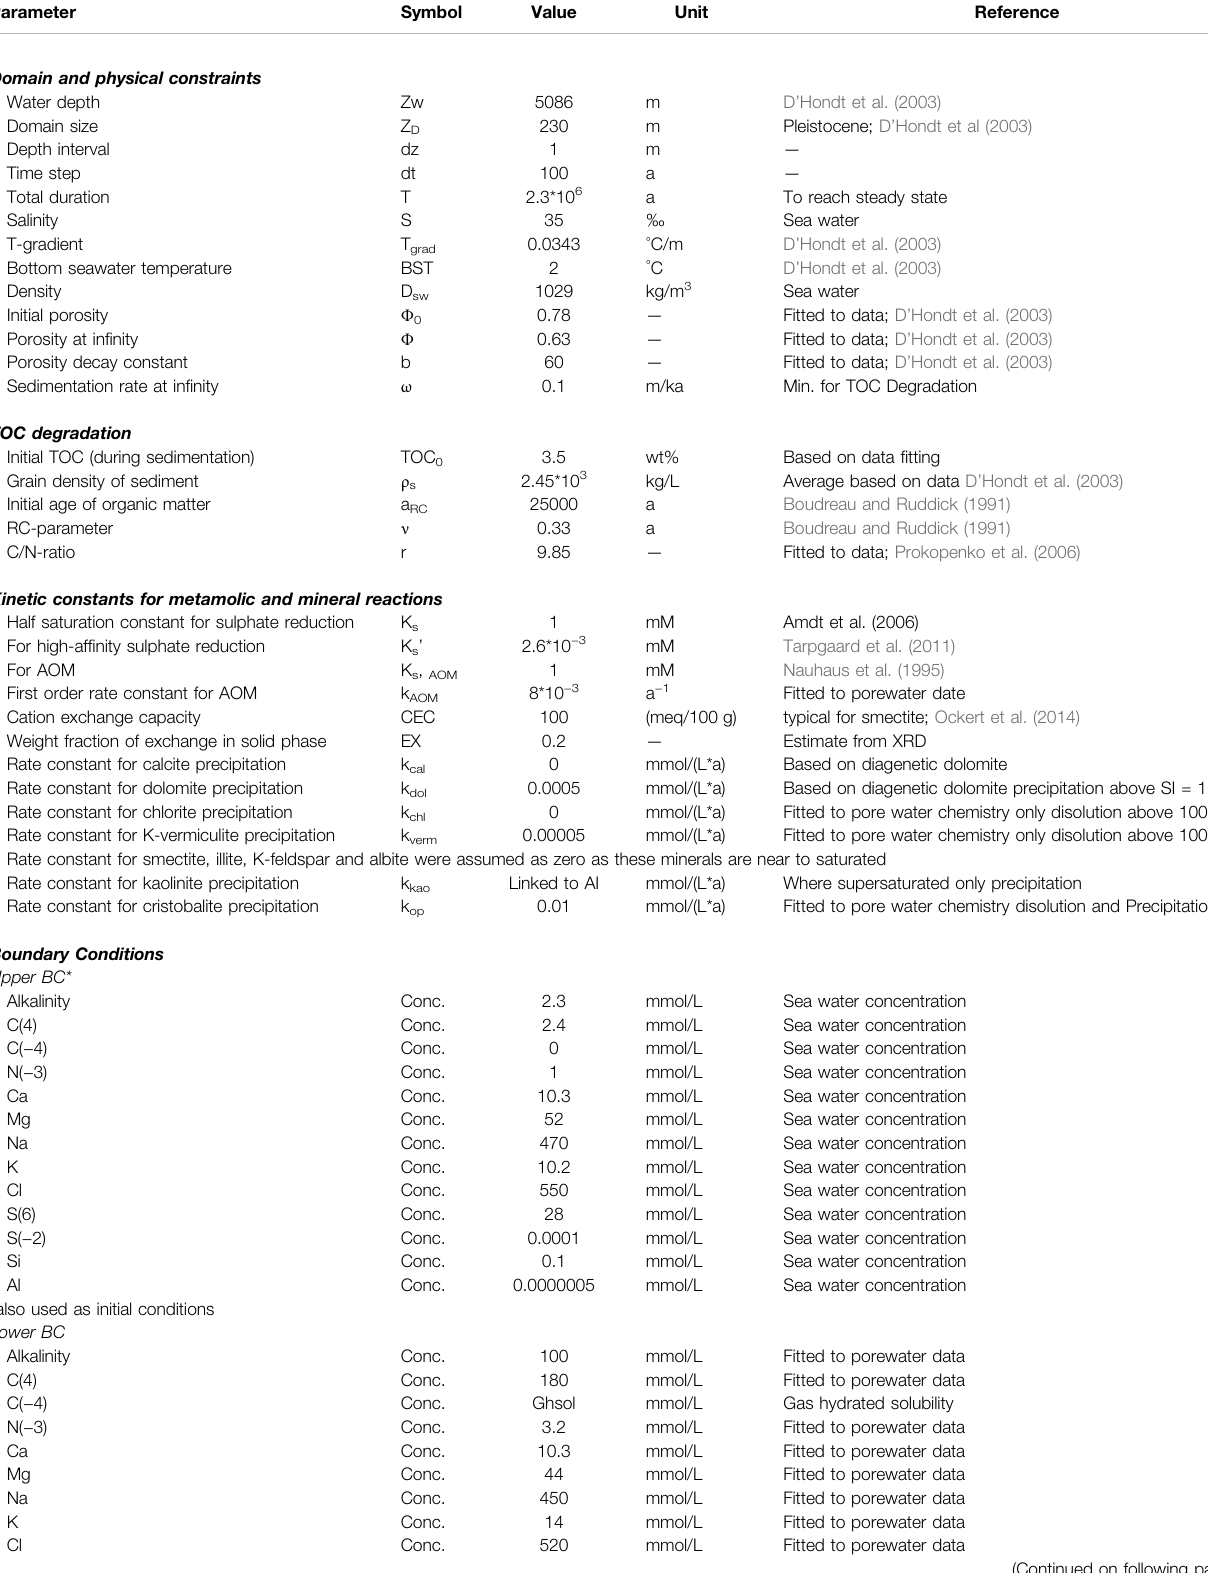
TABLE 1 | List of parameters and values used for the reaction transport model.